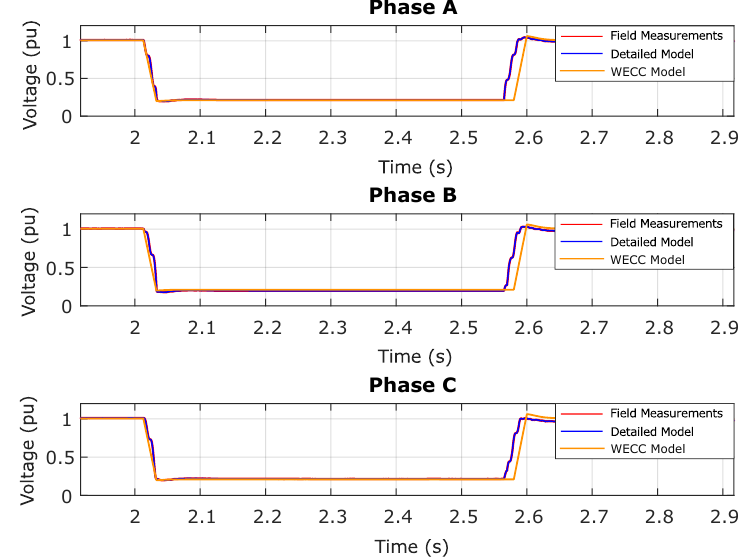
Figure 3. Root Mean Square (RMS) voltage in each phase: measured and